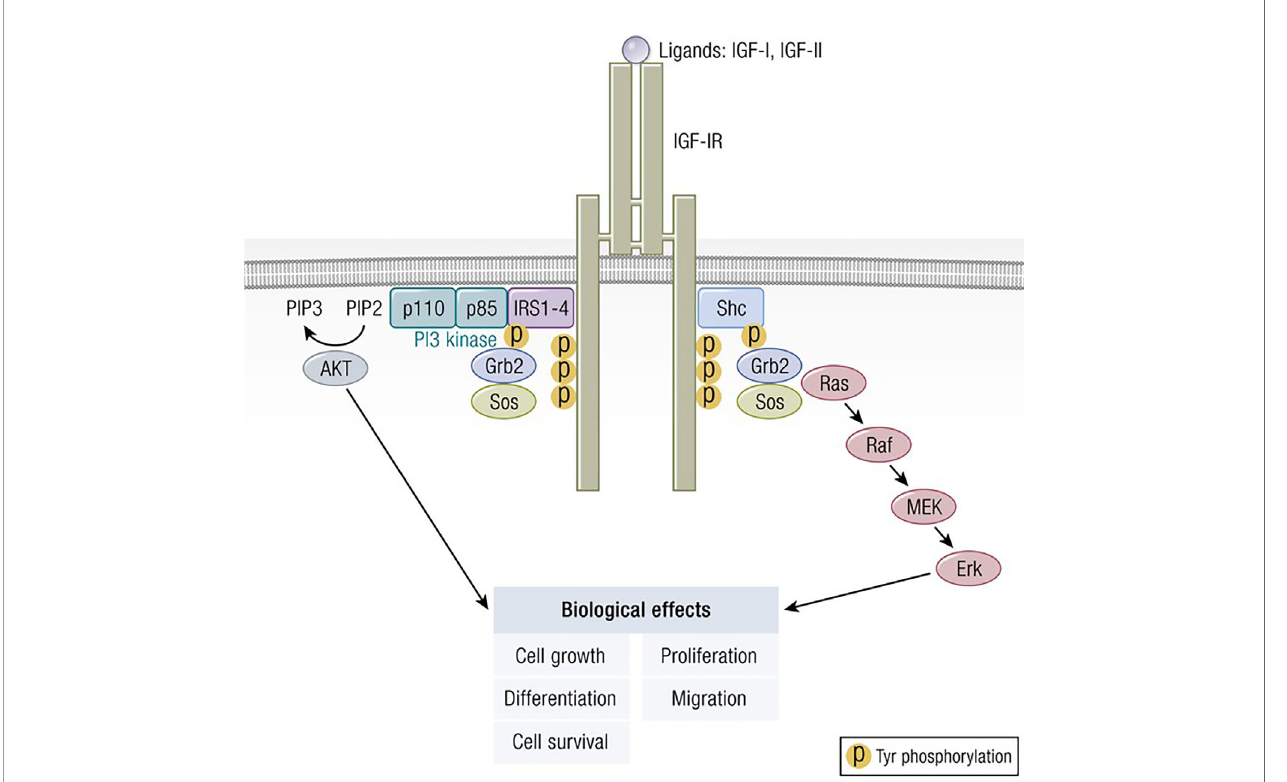
FIGURE 2 | Classical model of signaling through the IGF-IR. IGF-I ligation of IGF-IR most commonly results in canonical mitogen activated protein kinase (MAPK)/ Ras-Raf-Erk and phosphatidylinositol-3-kinase/AKT/mTOR (PI3K/AKT) phosphorylation, critical to downstream signaling and the activation of targeted genes associated with IGF-I responses. Adapted from Worrall et al. Novel Mechanisms of Regulation of IGF-1R Action: Functional and Therapeutic Implications. Pediatr Endocrinol Rev. 2013